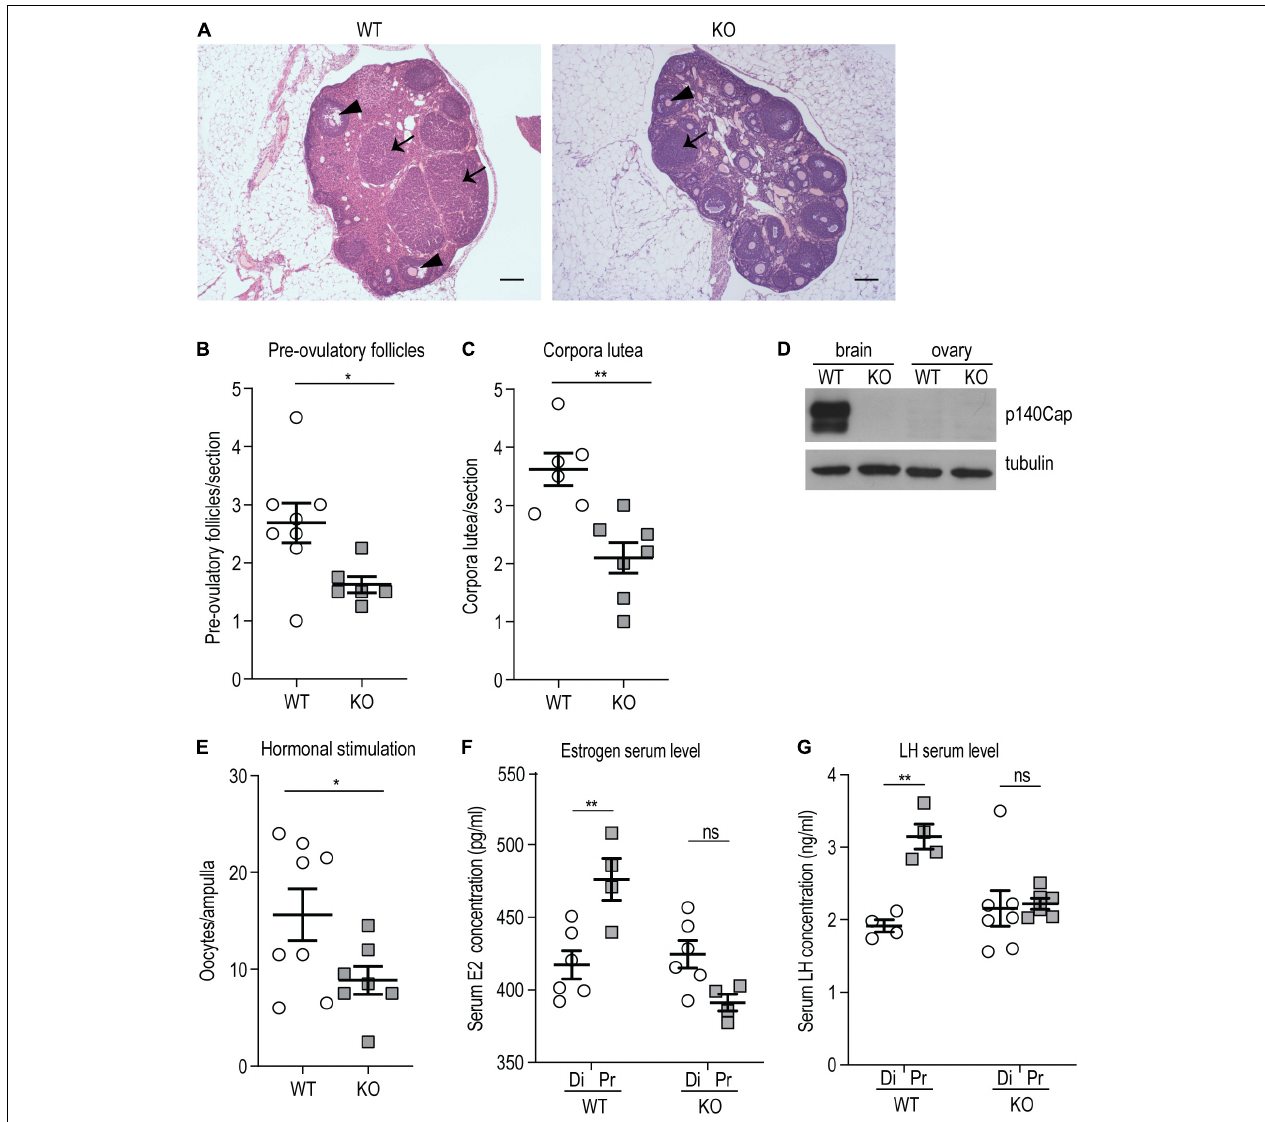
FIGURE 2 | p140Cap KO female mice show ovarian defects. (A) Representative images of ovary sections from P120 p140Cap KO and WT mice. Arrows indicate corpora lutea , arrowheads indicate pre-ovulatory follicles. Scale bar = 500 µ m. (B) Number of pre-ovulatory follicles per section in p140Cap KO and WT ovaries. n = 8 ovaries WT; 6 ovaries KO. Unpaired, two-tailed Welch’s t -test, P = 0.02. (C) Number of corpora lutea per section in p140Cap KO and WT ovaries. n = 6 ovaries WT; 7 ovaries KO. Unpaired, two-tailed t -test, P = 0.002. (D) Protein level of p140Cap expression in the total brain and ovary of p140Cap KO and WT mice, evaluated by western blot. Protein extracts from p140Cap KO and WT tissues were run in 6% SDS-PAGE. Membranes were decorated with anti-p140Cap antibody (top) and anti-tubulin antibody, as loading control (bottom). (E) Number of oocytes per ampulla from p140Cap KO and WT mice. Ovulation was stimulated by the injection of PMSG and HCG. n = 8 mice WT; 7 mice KO. Unpaired, two-tailed t -test, P = 0.05. (F) Estrogen (E2) serum levels in p140Cap KO and WT female mice measured by ELISA at diestrus and proestrus. n = 6 and 4 WT mice at diestrus and proestrus, respectively; 6 and 4 p140Cap KO mice at diestrus and proestrus, respectively. One-way ANOVA, P = 0.002; Sidak’s multiple comparison test, P ( proestrus WT vs diestrus WT ) = 0.002; P ( proestrus KO vs diestrus KO ) = 0.96. (G) LH serum levels in p140Cap KO and WT female mice measured by ELISA at diestrus and proestrus. n = 4 WT mice at diestrus and proestrus; 7 p140Cap KO mice at